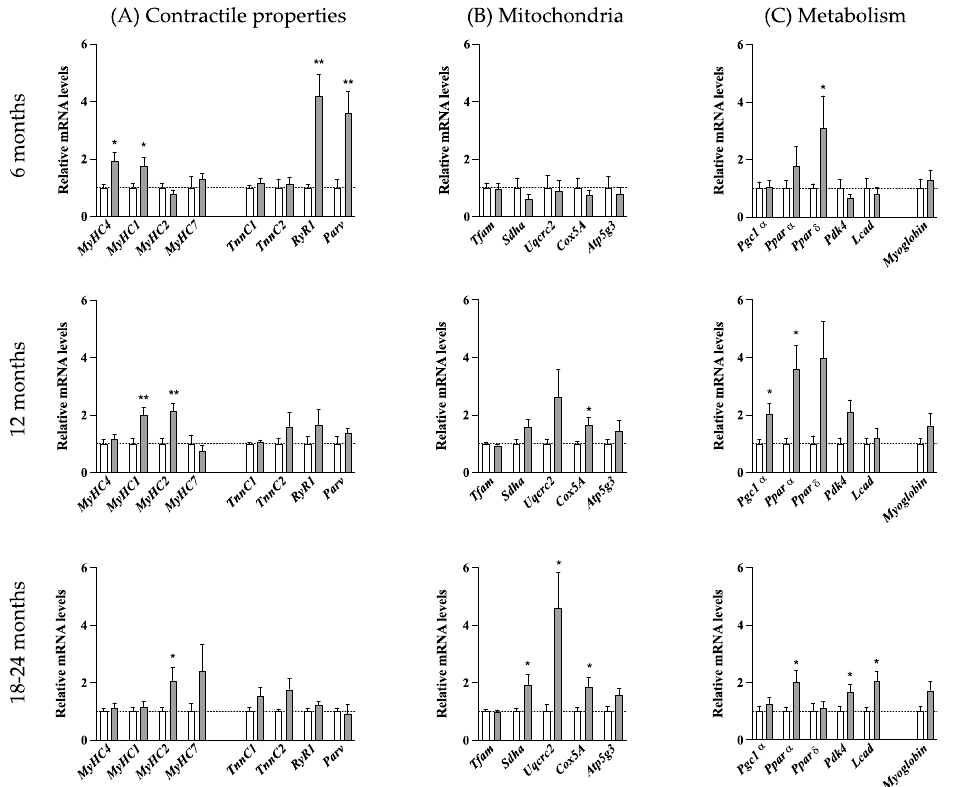
Figure 8. Molecular changes properties of the tibialis anterior muscle with age. Relative mRNA levels of molecules involved in contractile properties ( A ), in mitochondria function ( B ), and in metabolism ( C ) were evaluated by qPCR at the indicated ages in tibialis anterior of nTg and HE mice. Histograms represent mean fold change from age-matched nTg mice ± SEM. ( A ): n = 14–20/group, ( B ): n = 6–8/group; ( C ): n = 5–15/group. * p < 0.05, ** p < 0.01, Student’s t -test.